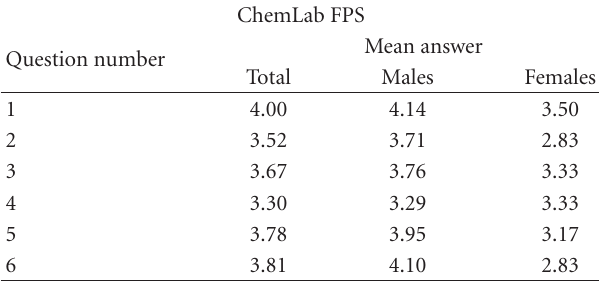
Table 6: List of mean answers for the ChemLab FPS